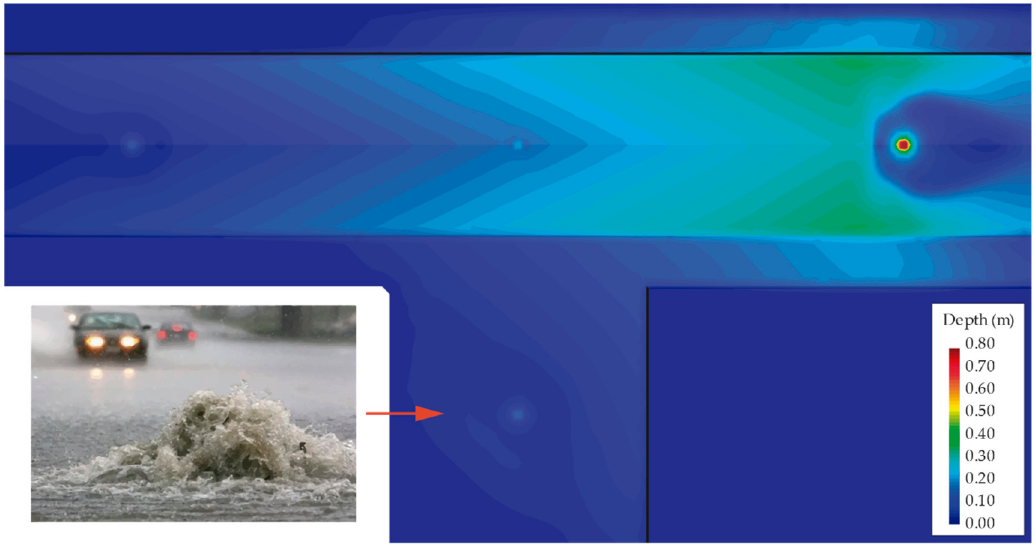
Figure 5. Results of maximum depths at surface and photography of a manhole flooding [34] that justifies the assumption that the main returned flow to the surface occurs through the manholes.